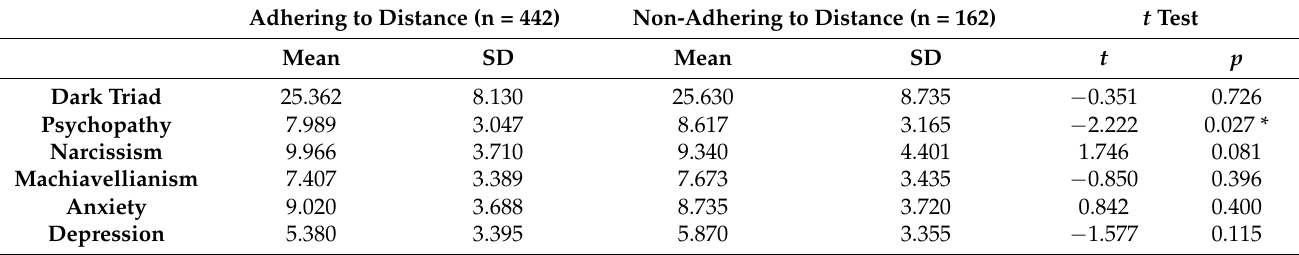
Table 5. Differences between individuals declaring adherence and non-adherence to social distancing restriction. Adhering to Distance (n =